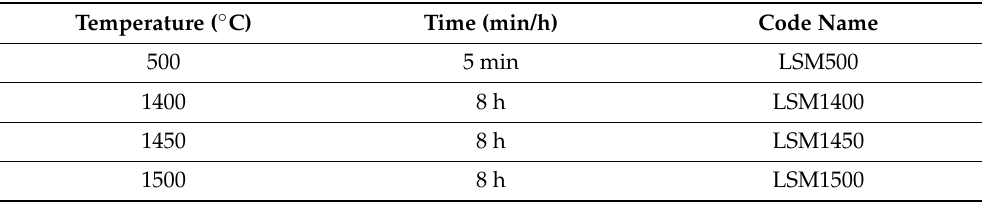
Table 5. La 0.6 Sr 0.4 MnO 3 sample nomenclature and